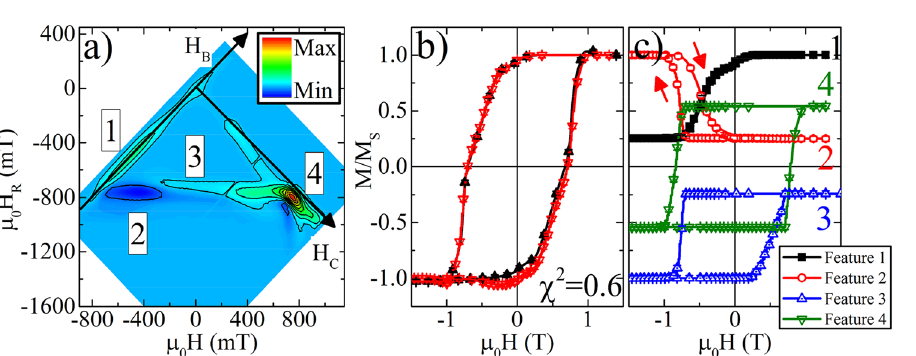
Figure 6. FORC distribution of ( a ) Fe/SmCo exchange-spring film, ( b ) directly measured (black, solid) and FORC reconstructed (red, open) major loop, and ( c ) phase separated loops identified with features 1–4, labeled in panel ( a